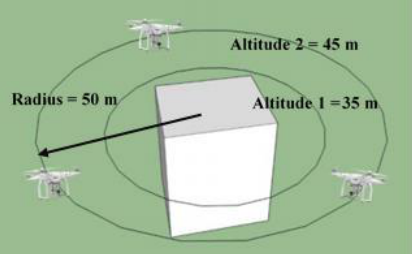
Figure 3. Point of Interest flight mode for data acquisition